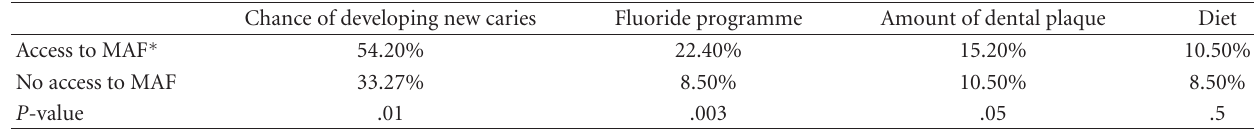
Table 2: Di ff erences in mean risk profiles and components for di ff erent social groups. Chance of developing new